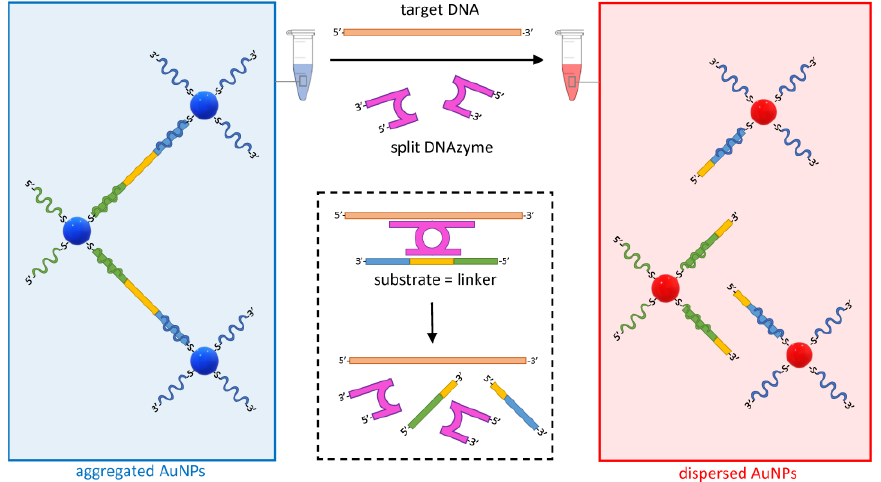
Figure 6. Dispersion of AuNPs mediated by the target-specific activation of a split DNAzyme (purple). The hybridization of designer arms to the target DNA (orange) triggers the assembly of the DNAzyme and the activation of the catalytic arms that selectively cleave a complementary DNA sequence within the linker (DNA substrate in yellow). The cleavage of the linker promotes the dispersion of the otherwise complexed AuNPs. As the target DNA and the split DNAzyme are available for another cleavage cycle, the dispersion of AuNPs is sustained.